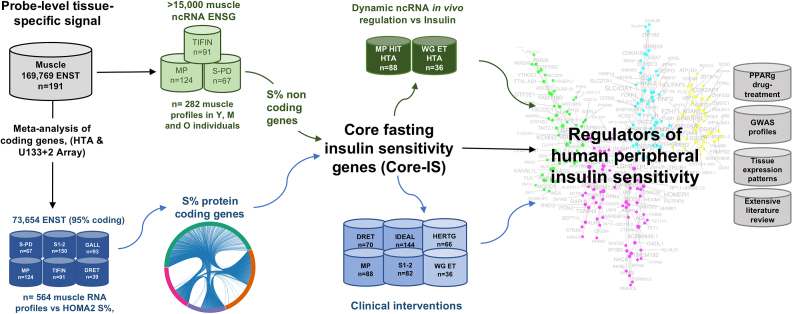

Analysis process. Human muscle biopsy RNA profiles came from clinical projects named STRRIDE I, II (S1–2) and III (S-PD), Meta-Predict (MP), TIFIN, DRET, Gallagher et al. (GALL), Weigert et al. (WG), Sears et al. (SEARS), Heritage (HERTG) and IDEAL (2,22,37,38,46,50–54,,56). The present project involved the production and analysis of 470 new samples profiled on the HTA 2.0 Affymetrix platform along with 144 new samples profiled on the Illumina 12 platform; and 466 of our previously published (22,37,53,54) U133+2 muscle RNA profiles and literature cohorts (where appropriate clinical data was available). The HTA 2.0 platform was processed with a 169 796 probe-set CDF (ENST), representing ∼18 000 protein-coding genes and ∼16 000 non-coding genes. The older array platform offered an opportunity to replicate protein-coding gene expression with 73 654 probe-sets (ENST) being common to the HTA 2.0 platform. All samples and clinical data underwent a rigorous quality control check to ensure that the microarray profile was technically robust (minimal variation in NUSE score), and the insulin and glucose values were within the operating range of the HOMA2-IR model (10). Less than 10% of any project samples were lost to lack of one of these two components. The HOMA2-IR model requires either ELISA (more specific insulin determination) or RIA (less specific) in p.mol.l and glucose in mmol.l and incorporates non-linear features of the glucose-insulin relationship. The HOMA2-IR is a bona fide physiological model for peripheral insulin resistance correlating with other more precise but less physiological models (10). We utilized the log10 transformed insulin sensitivity values (S%) as the input values for the linear covariate adjusted modeling of peripheral insulin sensitivity. A meta-analysis of the individual covariate adjusted P-values was aggregated using the Stouffer method and an FDR calculated (60). This process identified ∼1000 genes related to S%, of which >300 were consistently (directionality) regulated; yielding a ‘core fasting insulin sensitivity gene list’ (CORE-IS). Having identified this reproducible set of S% genes, the causal nature of these genes during dynamic regulation of S% was investigated using clinical intervention studies (22,37,53,54) and systems biology methodologies (data-driven co-expression analysis (77,136); protein–protein interaction databases (137), transcription factor binding-site analysis (63) and ‘guilt-by-association’ methodologies (138)).